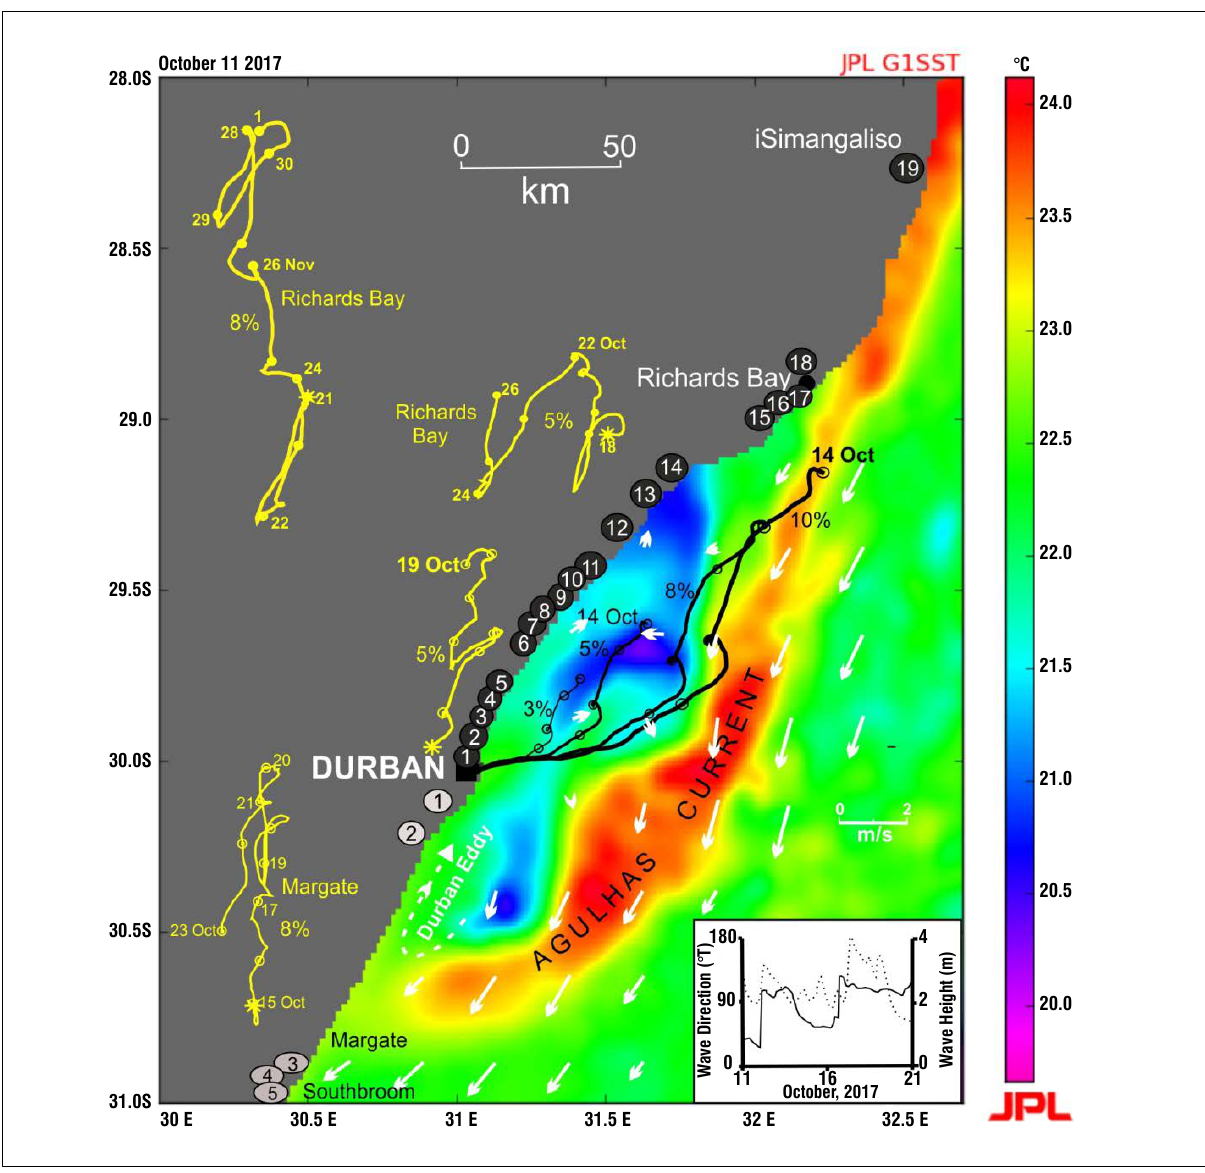
Image courtesy of the NASA Jet Propulsion Laboratory (JPL). Figure 3: A satellite image for 11 October 2017, depicting sea surface temperatures (scale on right) off the KwaZulu-Natal coast. The warm waters of the Agulhas Current are readily apparent, together with calculated geostrophic currents; currents south of Durban are for 20 October. Inshore the variable flows and cooler waters in the KZN Bight are evident, while the Durban eddy is also depicted. Sites of public reports of nurdles on beaches are given along the coast (see Table 1). Various progressive vector diagrams (PVDs) in October and November are shown starting at the star, with the relevant weather stations given and further day starts indicated by circles and day numbers. In particular, the black PVDs emanating from Durban use wind data from King Shaka Airport at Durban starting on 10 October, with the wind dispersion shown for 3%, 5%, 8% and 10%. In the bottom right-hand corner, hindcast wave direction and height (dotted) for 30°S and 31.5°E are given for 11 to 21 October